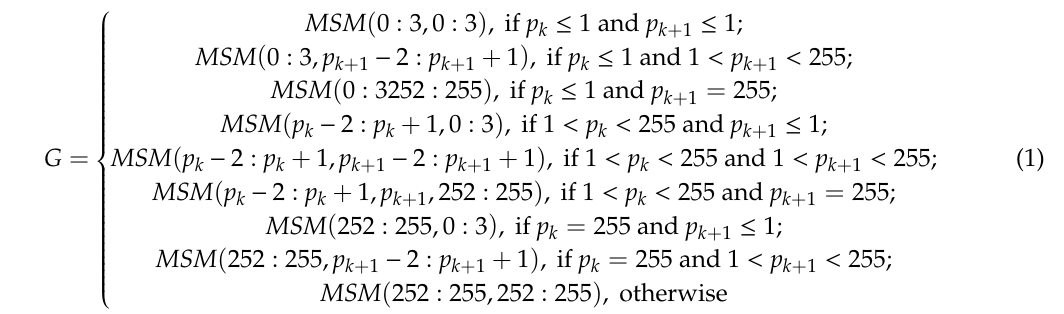
Figure 4. Mini-SuDoKu reference matrix.